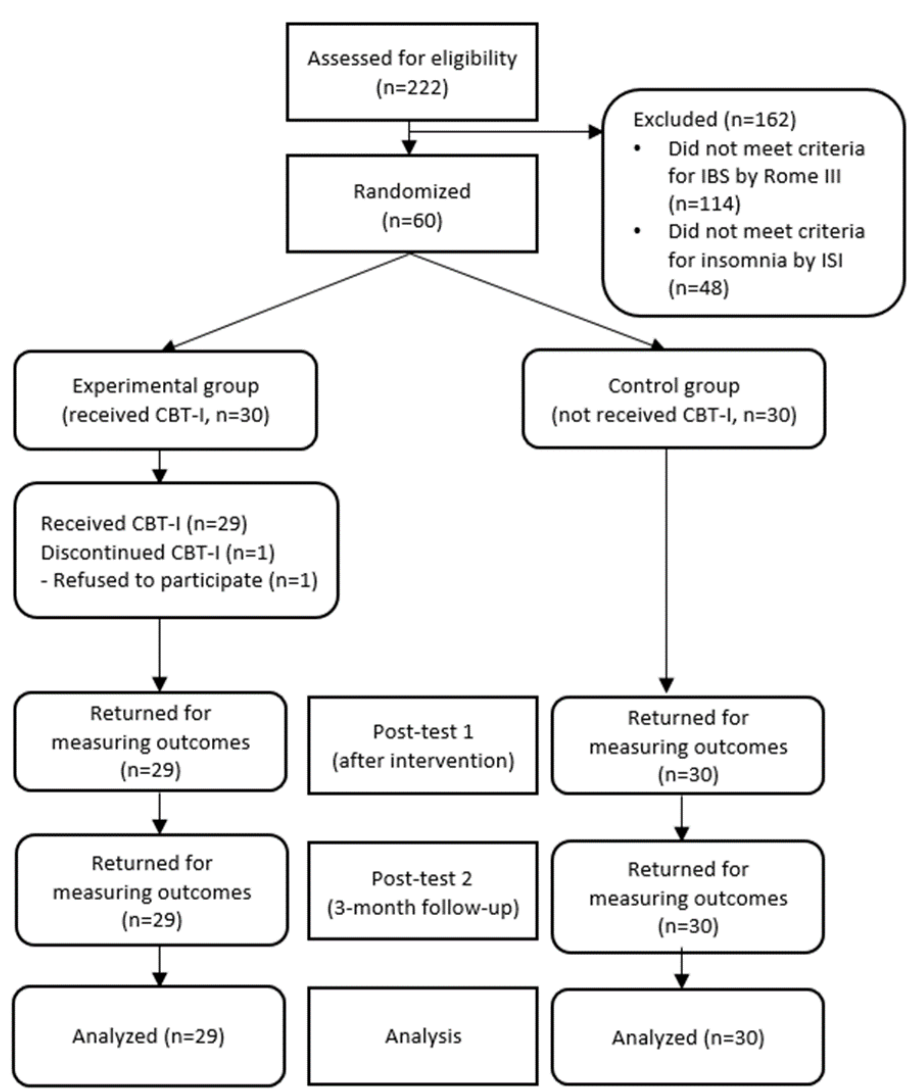
Figure 1. Flow diagram of inclusion and exclusion. ISI = insomnia severity index, CBT-1 = cognitive behavioral therapy for insomnia.